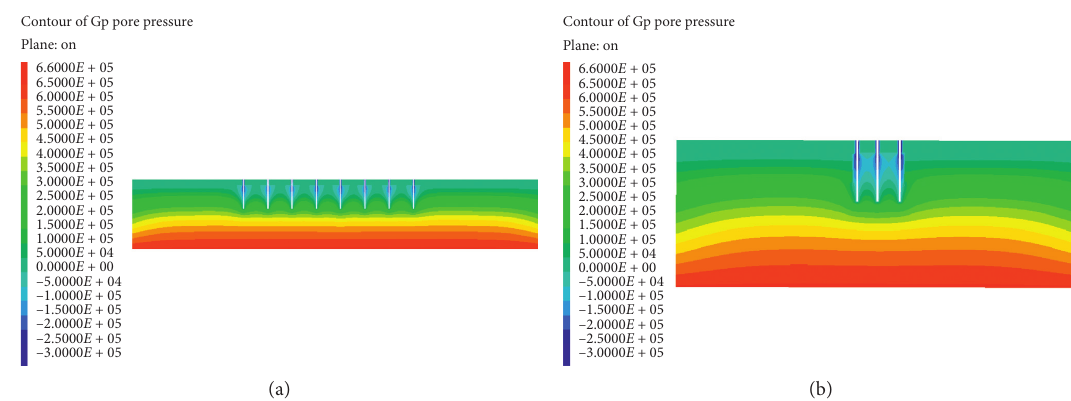
Figure 32: Group wells pore water pressure nephogram when the drawdown is stable (unit: Pa). (a) Three-dimensional diagram. (b) Cross section of the well